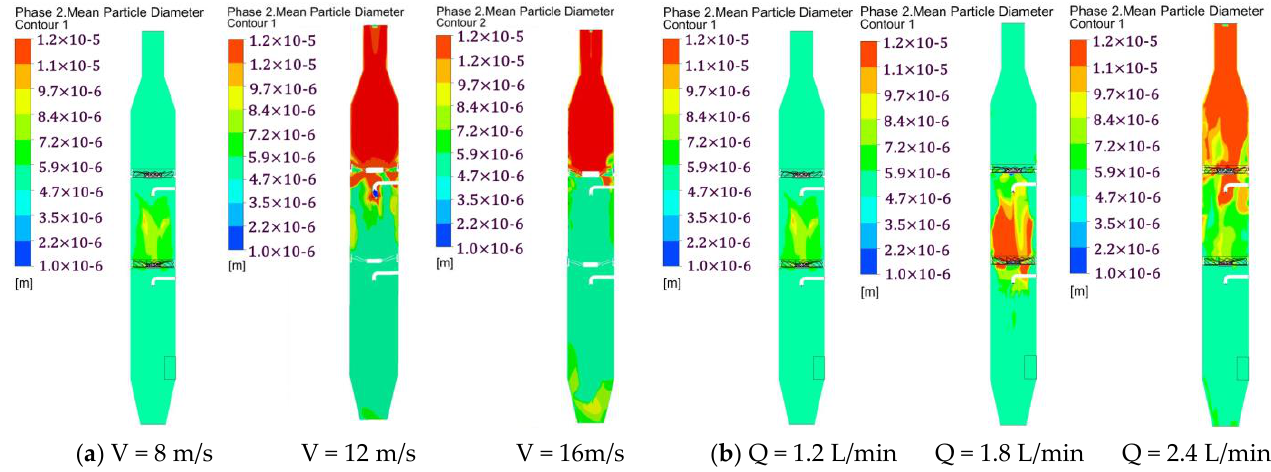
Figure 5. Particle size distribution under different conditions in section Y = 0 for ( a ) different gas velocities and ( b ) different spray volumes.